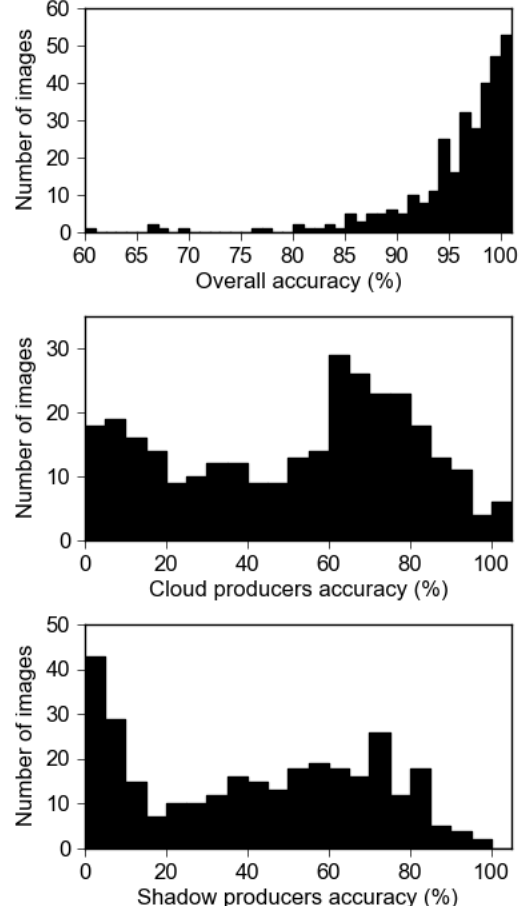
Figure 12. Histograms of overall accuracy, cloud producers accuracy and shadow producers accuracy for the 313 training/validation